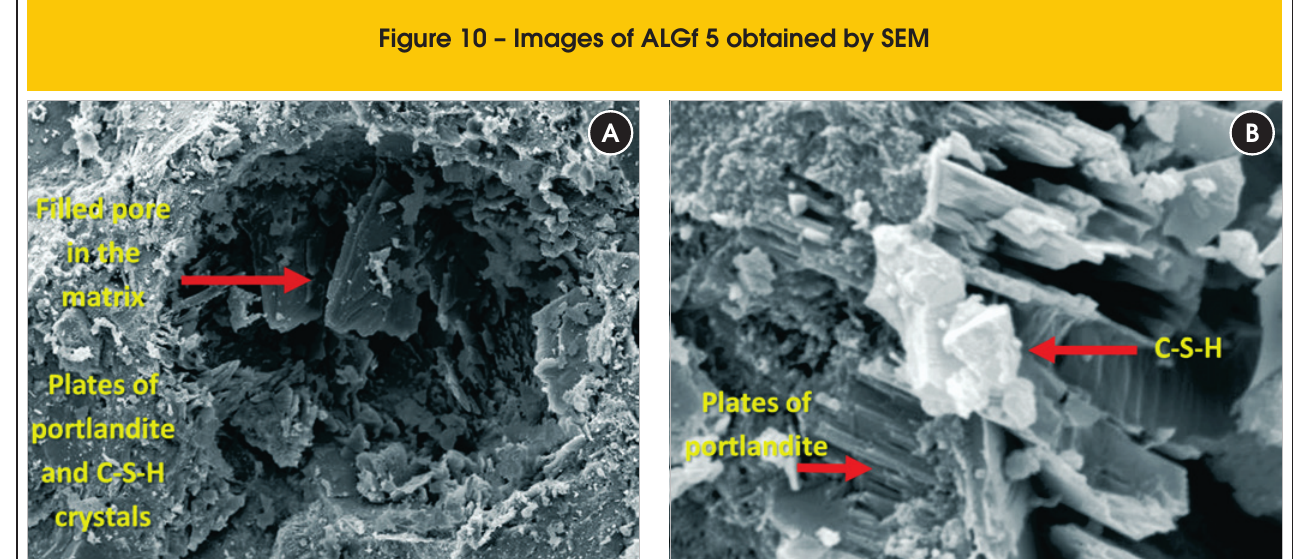
Figure 10 – Images of ALGf 5 obtained by